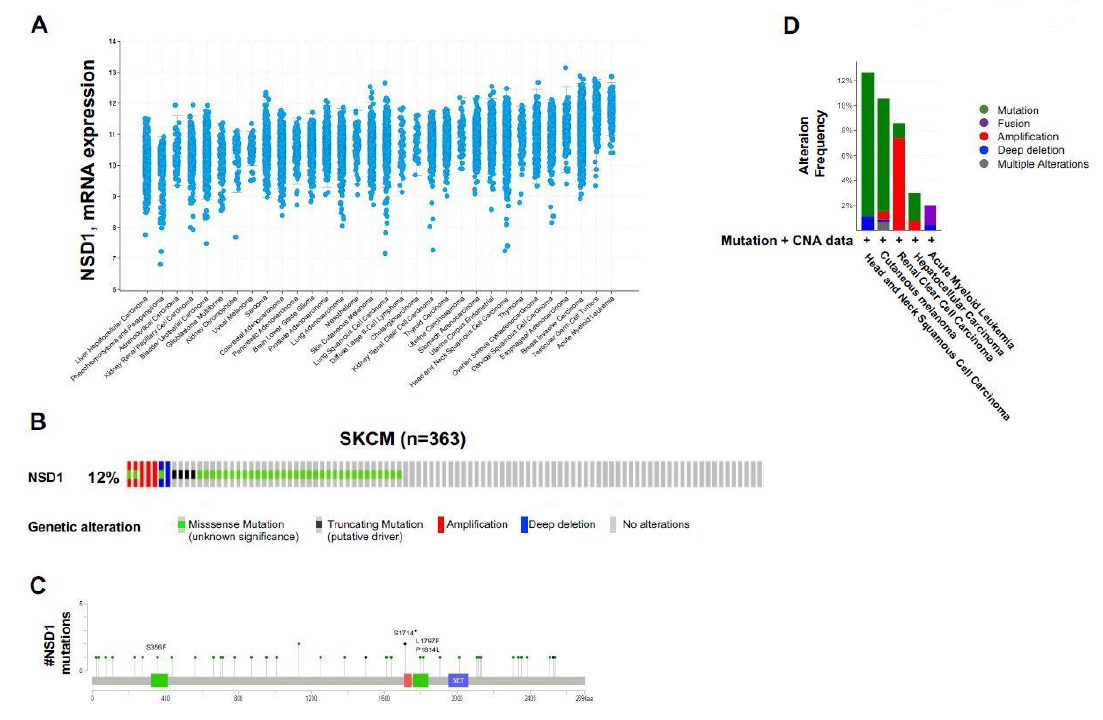
Figure 2. NSD1 expression and alterations in cancers. ( A ) NSD1 mRNA expression across TCGA tumor types. ( B ) Alterations in NSD1 gene are found in skin cutaneous melanoma (SKCM) ( n = 363). Each sample is represented as a column. The image included all the NSD1 alterations found in the cohort and was cut down to fit the figure. ( C ) Lollipop mutation diagram mapper displaying NSD1 mutations in the SKCM cohort. Lollipop representations indicate the location of 4 nonsense and 39 missense mutations affecting NSD1. The lollipops are colored with respect to the corresponding mutation types. Truncating mutations are in black circles, missense mutations are in green circles. NSD1 functional domains with their respective mutations are indicated: PWWP domains are in green, SET domain is in blue and PHD finger is in red. Same height lollipops above the line indicate single NSD1 mutation per position, whereas the higher lollipops above the line indicate 2 mutations at a single position. These data were extracted from the SKCM TCGA PanCancer Atlas 2018 cohort of 363 patients. These figures were adapted from cBioPortal.org. ( D ) Alteration frequency of NSD1 mutations and copy number alterations data in Skin cutaneous melanoma compared to Head and neck squamous cell carcinoma, renal clear cell carcinoma, hepatocellular carcinoma and acute myeloid leukemia. Alterations are distinguished with specific colors: missense mutations are in green, amplifications in red, deep deletions in blue, fusions in purple and multiple alterations in gray. All studies were selected from the TCGA PanCancer Atlas on cBioportal.org.